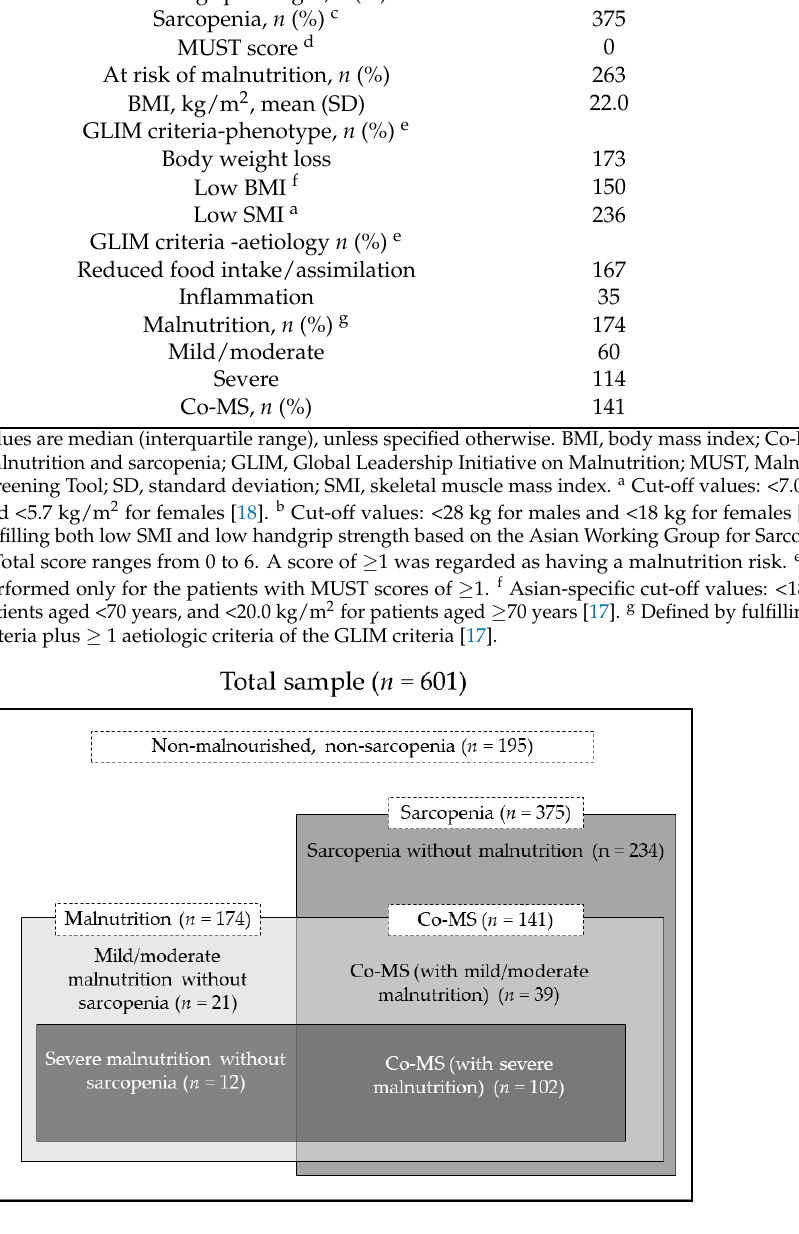
Figure 2. Overlapping of malnutrition and sarcopenia. Co-MS: Coexistence of Malnutrition and Sarcopenia.